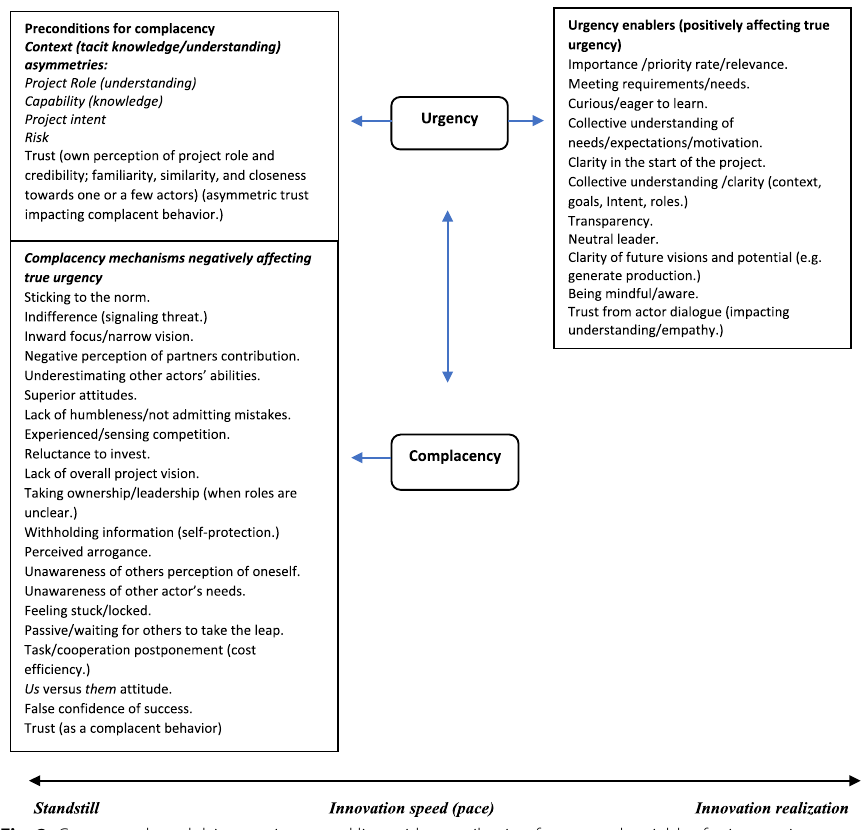
Fig. 2 Conceptual model: innovation speed line with contributing factors and variables for innovation